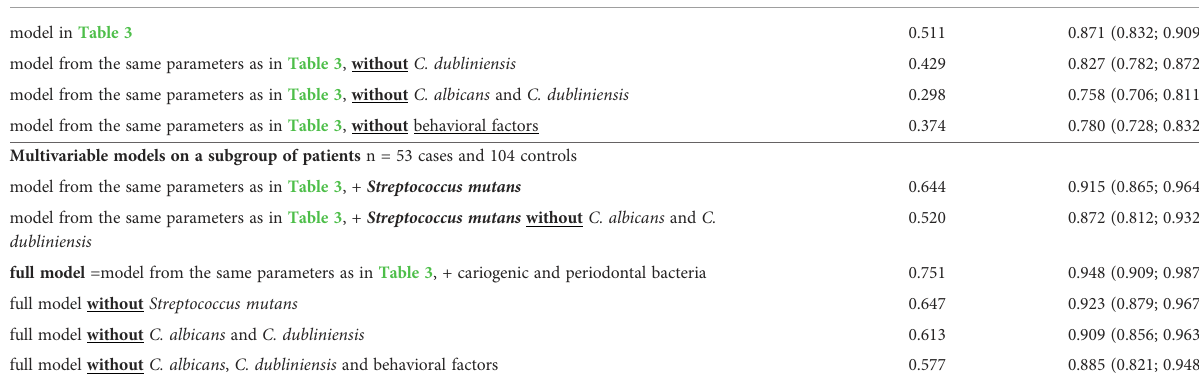
TABLE 4 Comparison of multivariable models predicting sECC status. Multivariable models n = 164 cases with sECC and 147